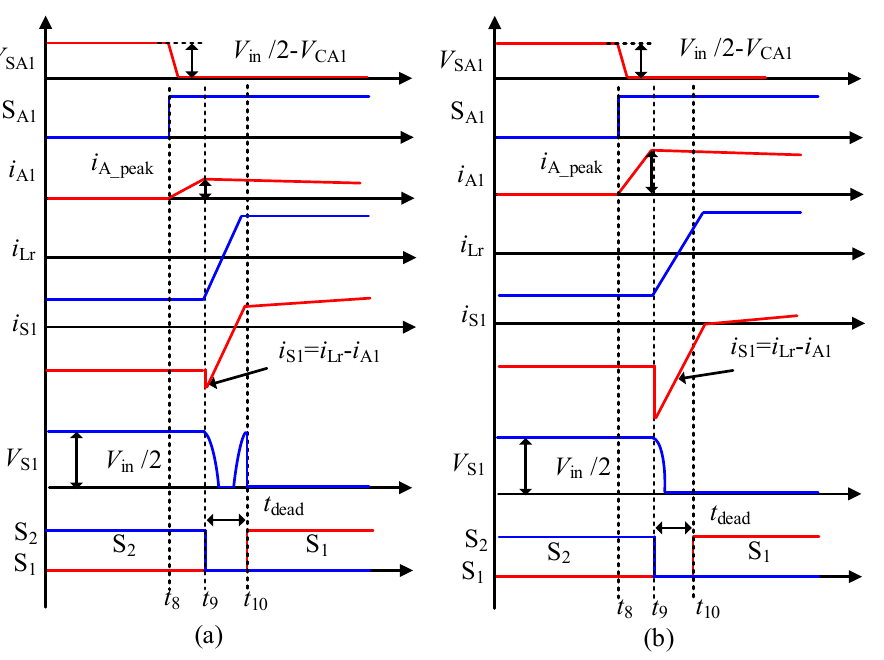
Figure 6. The turn-on process of the main switch S 1 ( a ) with small auxiliary current, ( b ) with large auxiliary current.